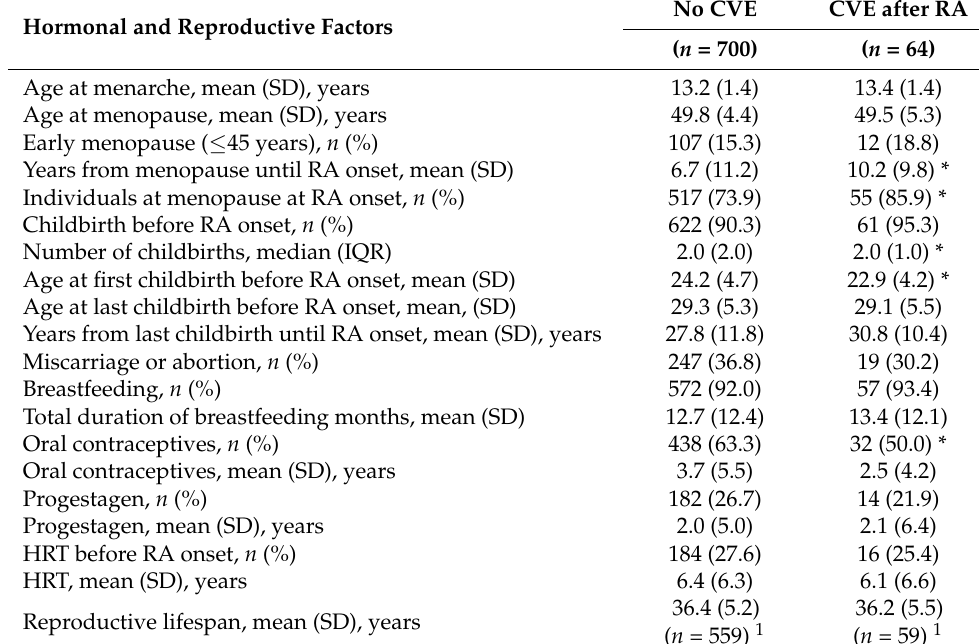
Table 3. Characteristics of hormonal and reproductive factors in patients with no CVE ( n = 700), and CVE after RA onset ( n =